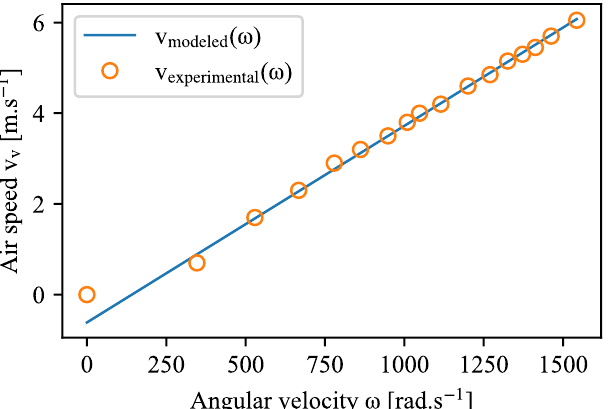
Figure 6. Air velocity v v ( t ) as a function of fan’s angular velocity ω ( t )